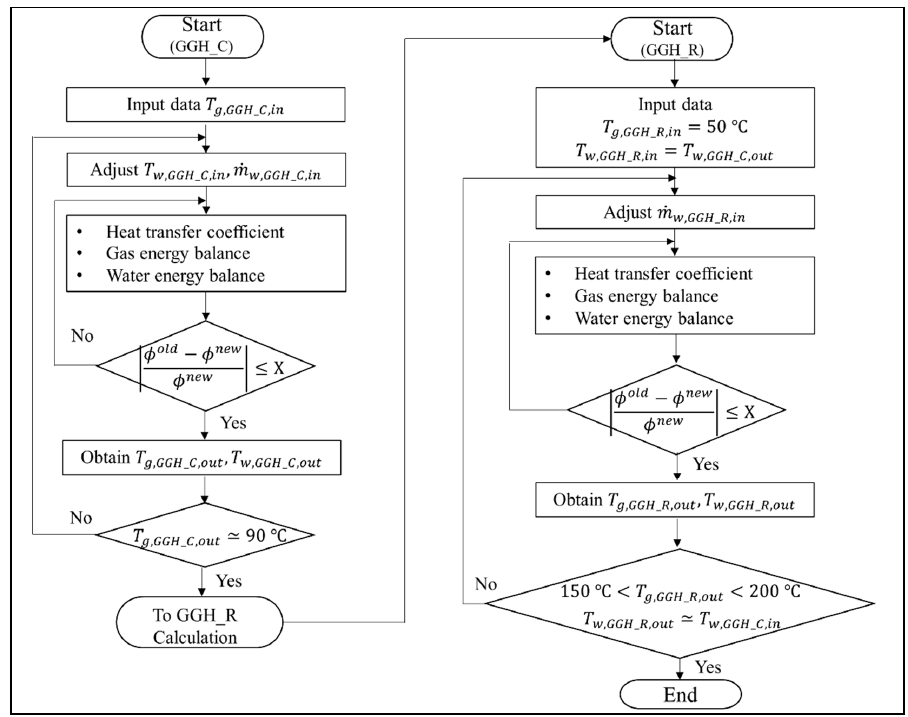
Figure 5. Calculation process to derive the operating conditions for the gas–gas heater (GGH) cooler and reheater in the new process.